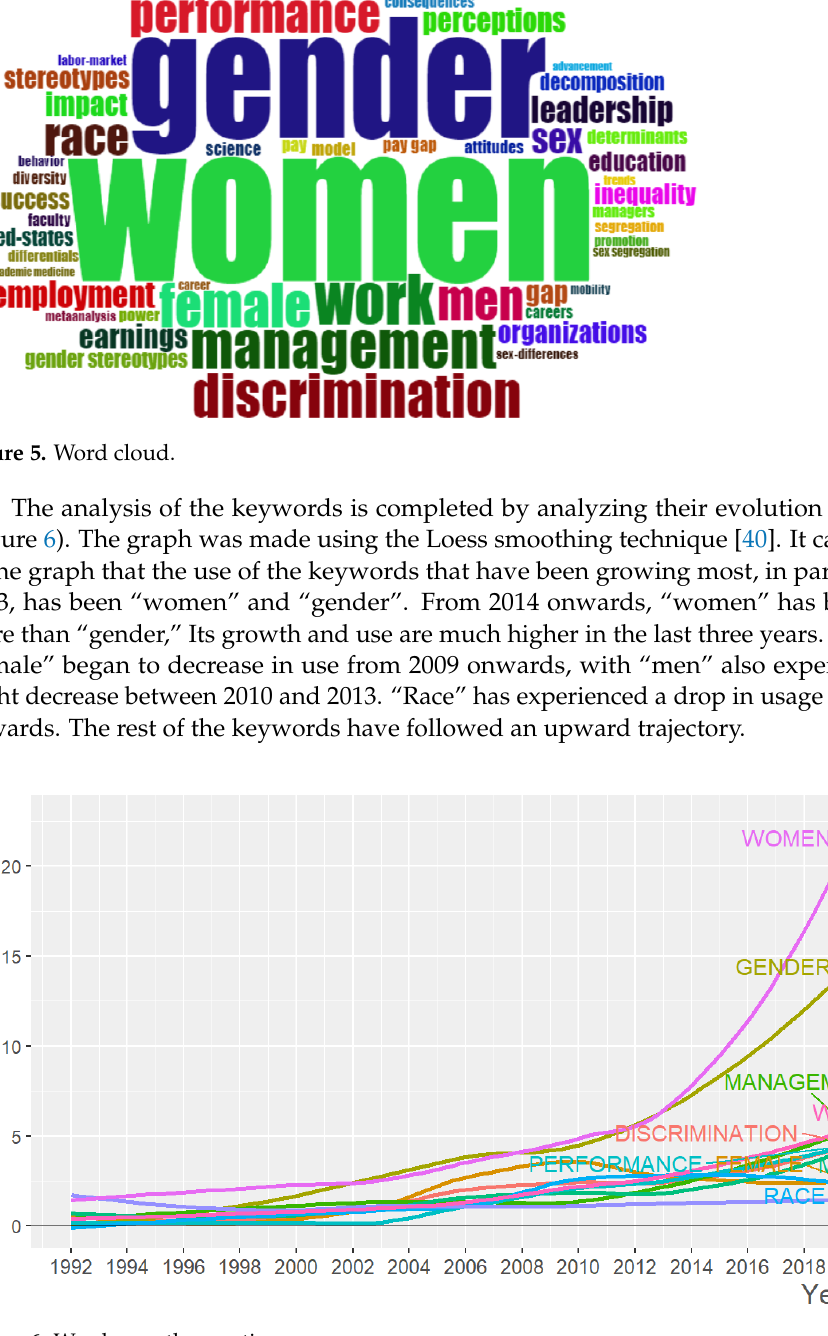
Figure 6. Word growth over time.